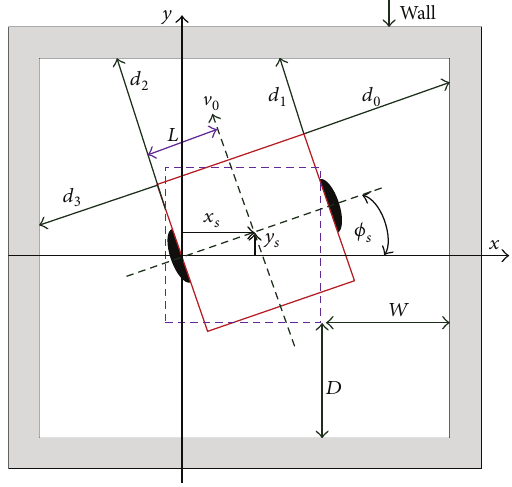
Figure 4: Stability analysis model.